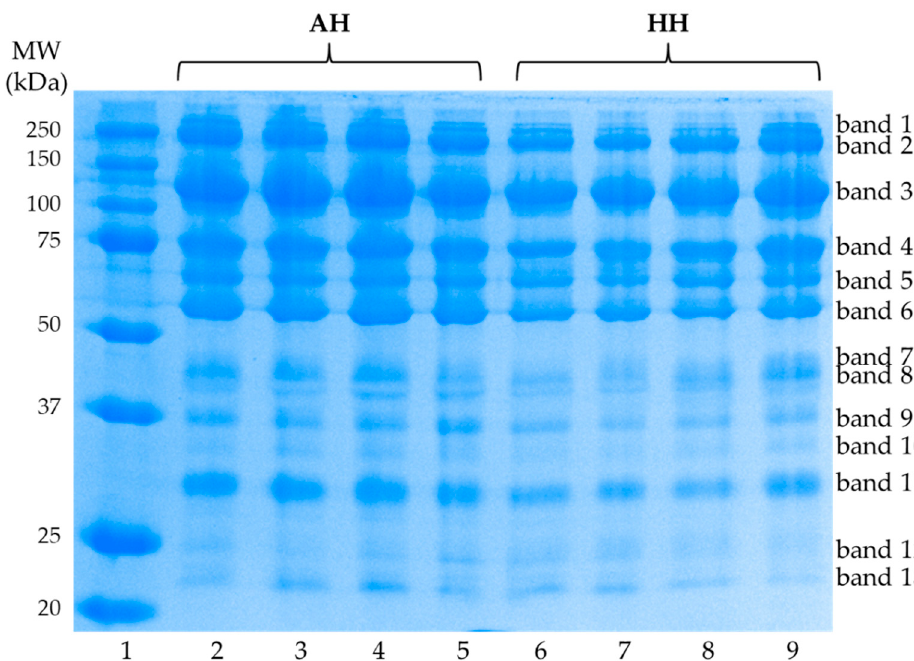
Figure 2. Sodium dodecyl sulfate polyacrylamide gel electrophoresis (SDS-PAGE) of globular proteins extracted from egg yolks obtained from Nera Atriana laying hens (AH-lanes from 2 to 5) and commercial hybrid hens (HH-lanes from 6 to 9). In lane 1 the molecular weight (MW) markers were loaded. The figure is representative of all the analyzed samples.